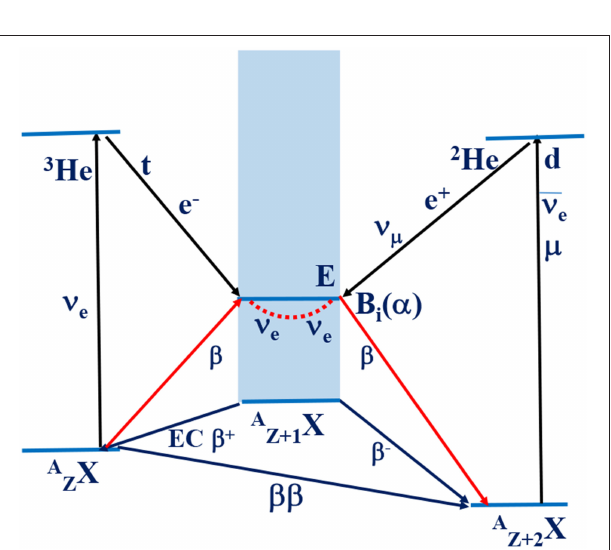
are discussed in DBD review articles [1, 3, 12]. The decay